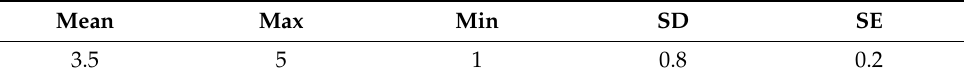
Table 10. Descriptive statistics for items regarding user interest in emotional messages.